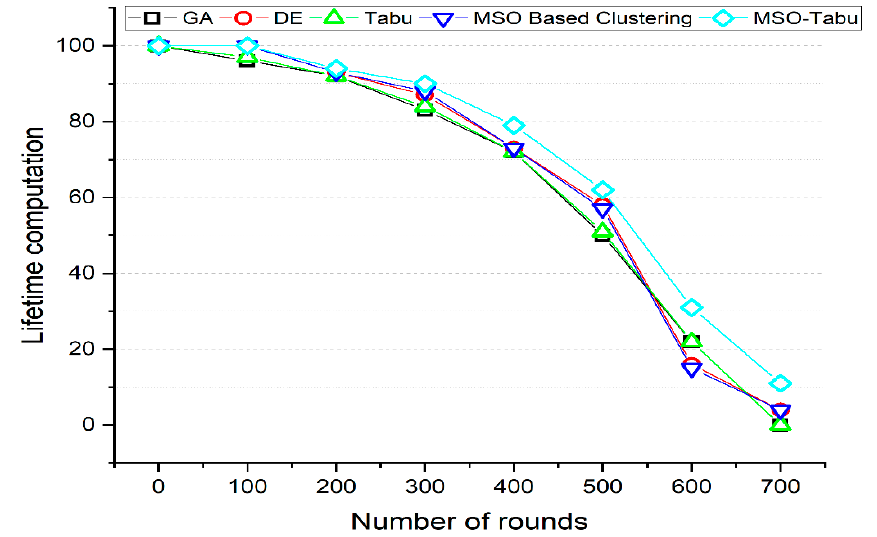
Figure 4. Lifetime Computation for MSO-Tabu.